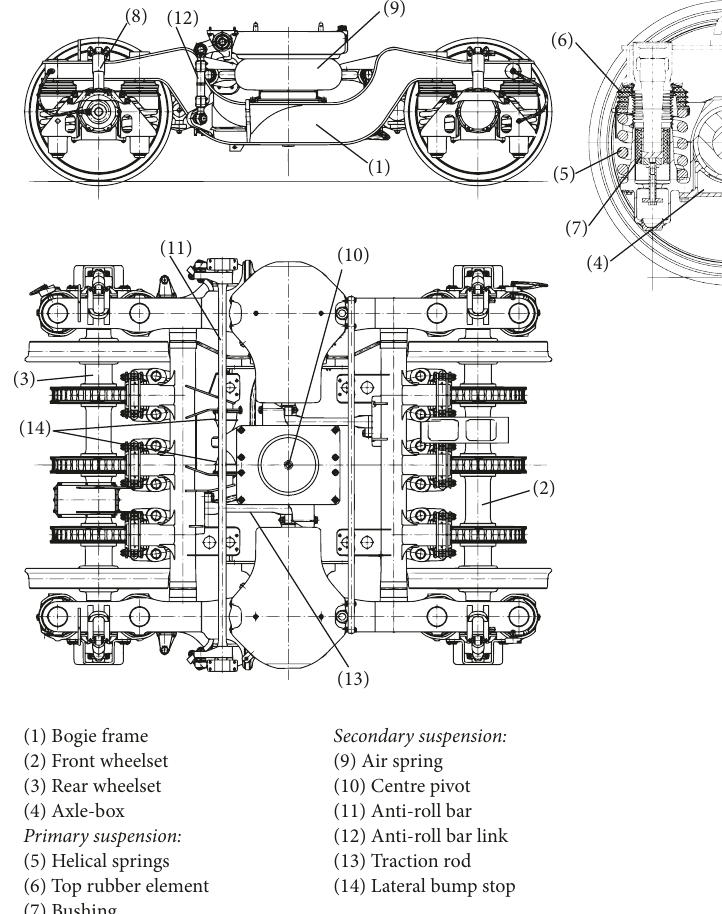
Figure 2: SF400 Bogie technical drawing, courtesy of Magliola s.p.a leading the CARITAS project.